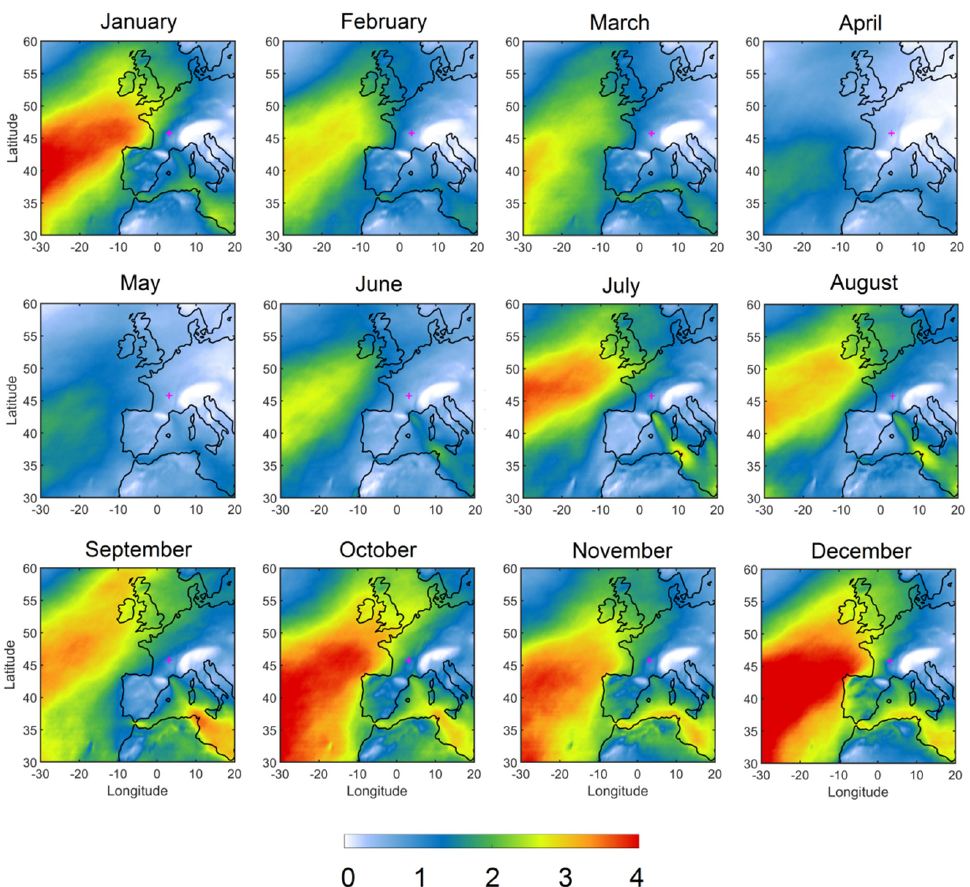
Figure 2. Average number of AR days each month over the period 1980–2020 from January ( top left ) to December ( bottom right ). The location of Clermont-Ferrand is marked by a pink cross.